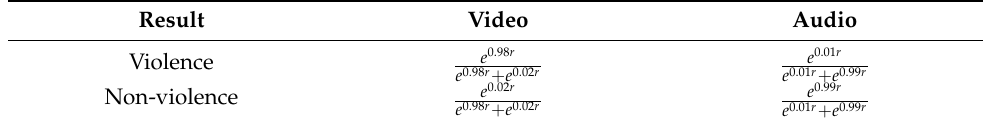
Table 5. Recognition result of the improved BPA functions.